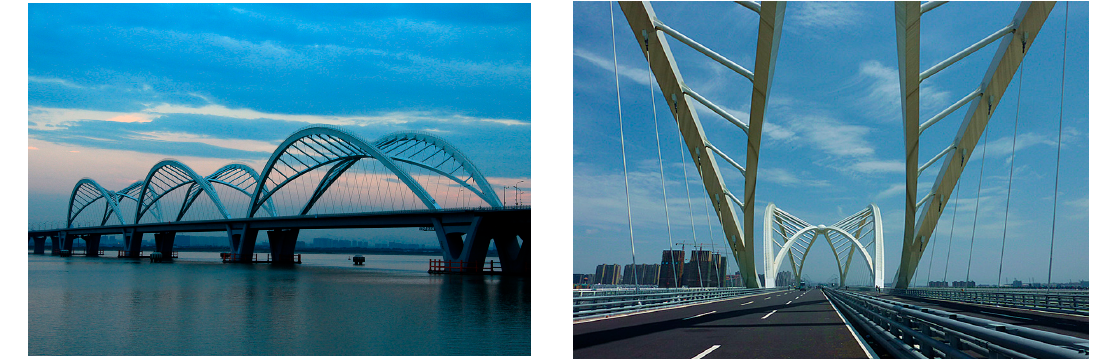
Figure 3. Overview of the Jiubao Bridge.